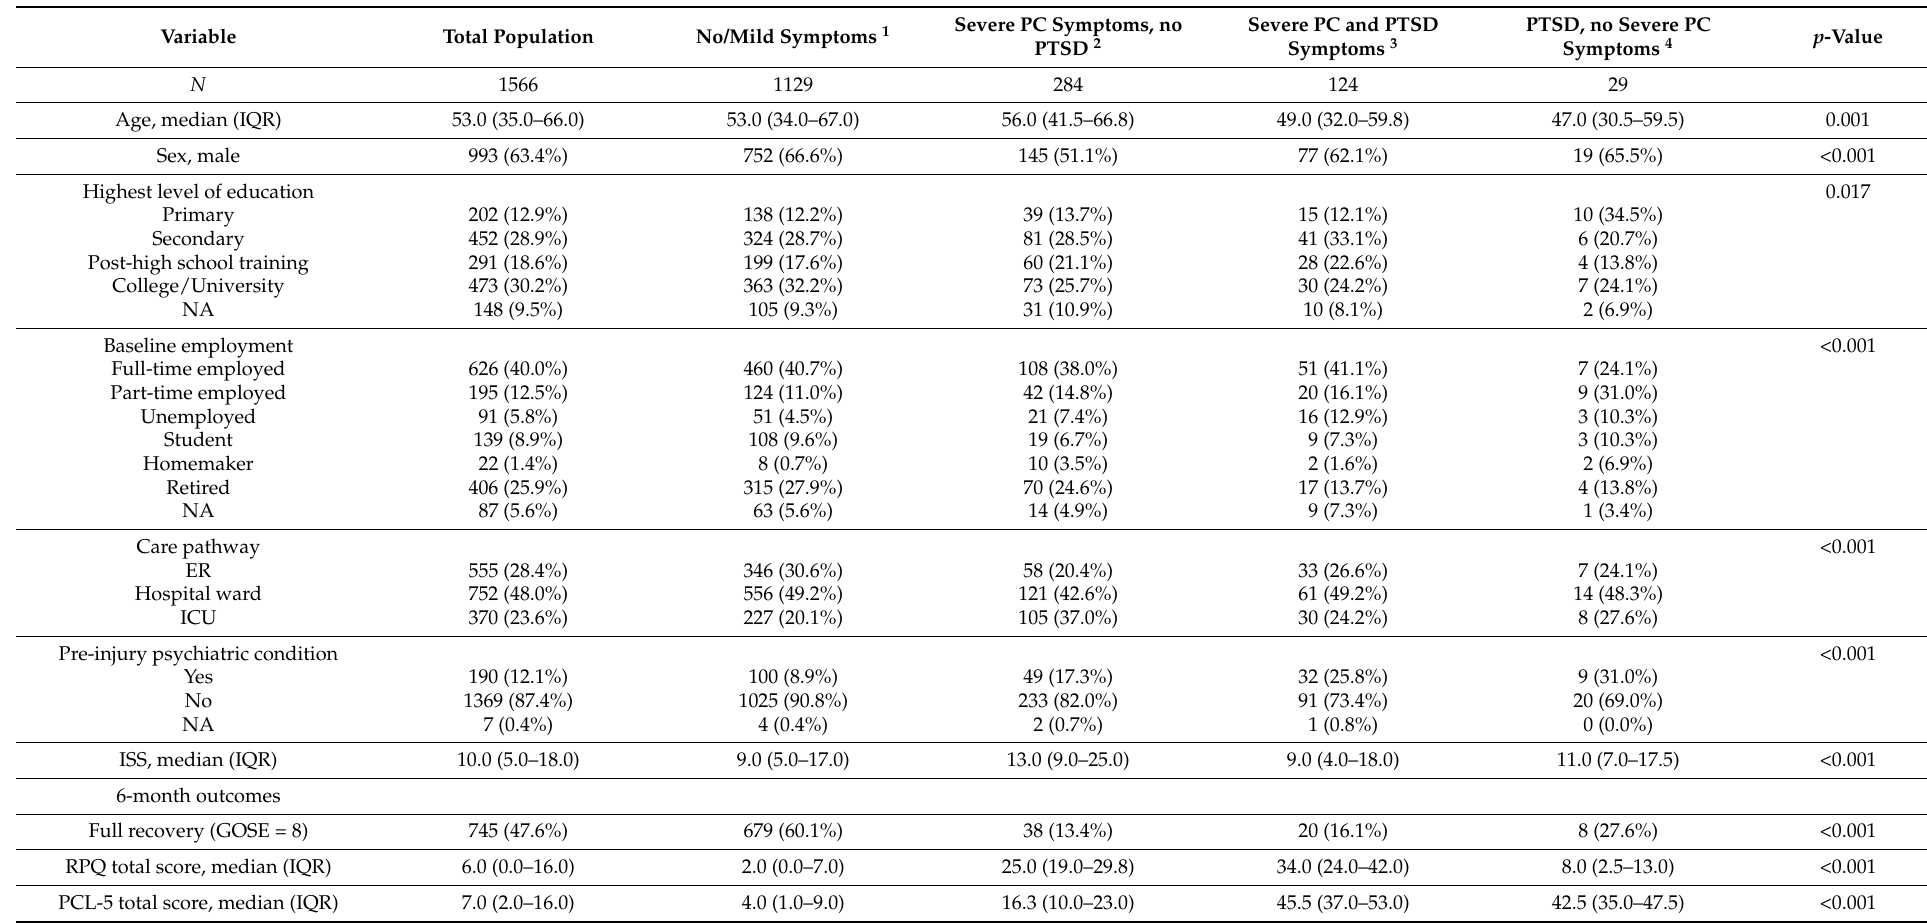
Table 1. Descriptive statistics of the total sample and for patients with severe PC and/or PTSD symptoms, at six months